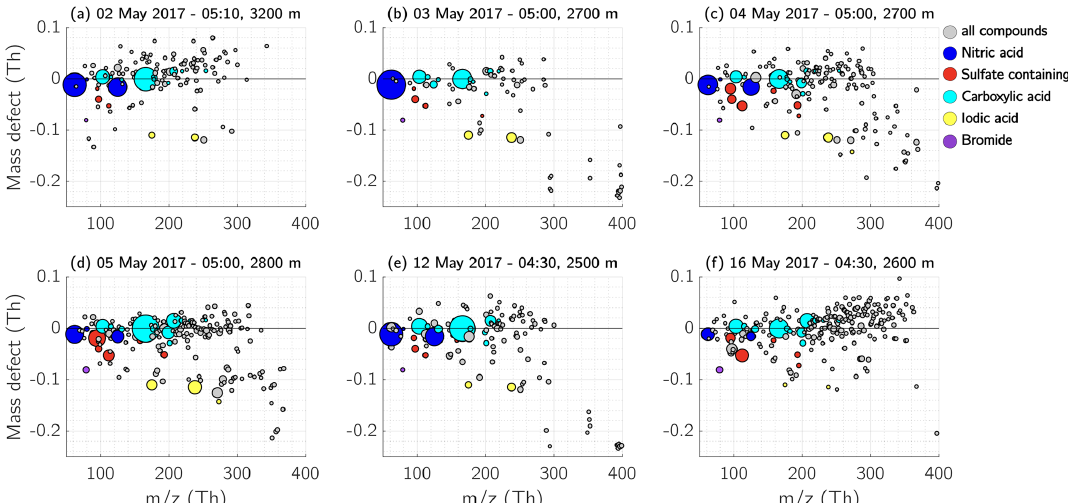
Figure 16. Mass defect of the free troposphere during early morning. Each panel from (a) to (f) shows the detected ions in the FT during the six different measurement days. The shown observations were performed during early morning hours between 04:30–05:00EET. Nitric-acid- containing ions are coloured dark blue, ions and clusters with sulfuric acid, MSA, or both, and the SO − containing carboxyl functional groups are depicted in cyan, and iodic-acid- and iodine-containing compounds in yellow. The size of the dots corresponds to the measured signal (ionss − 1 ).